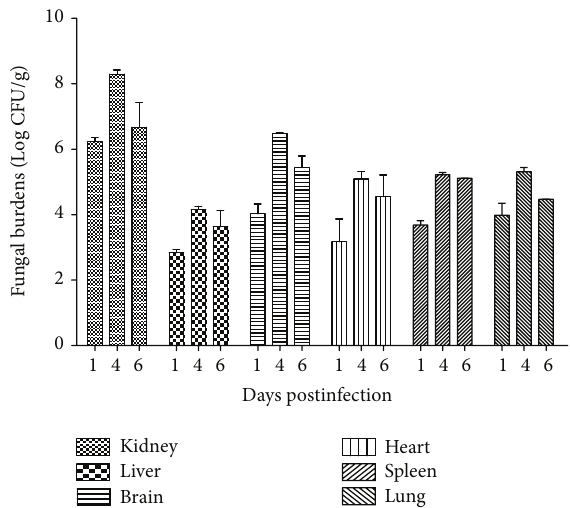
Figure 6: Dynamic changes of tissue fungal burdens. Tissue fungal burdens showed a transient increase during the infection period. And the kidney suffered the highest CFU